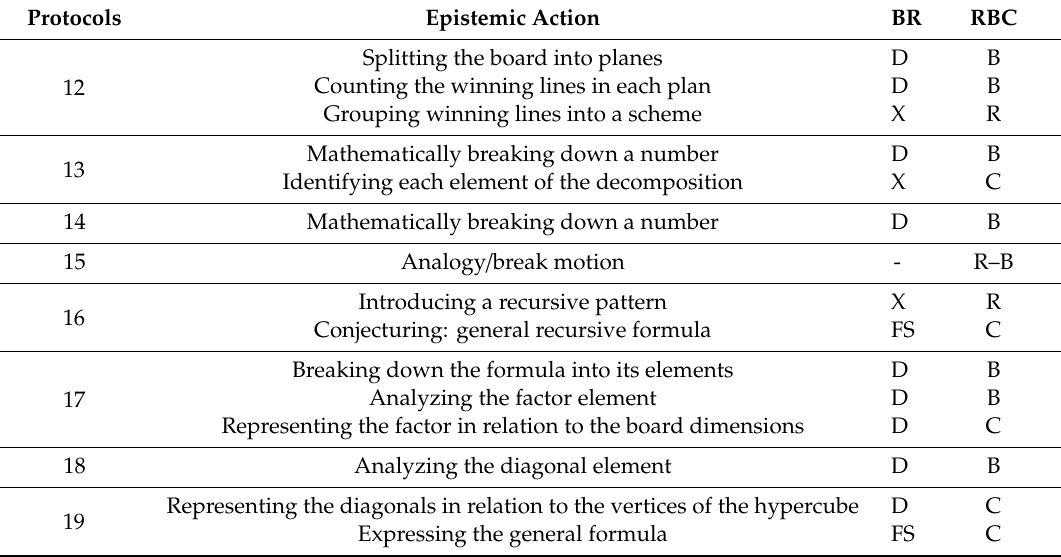
Table 4. First excerpt of Student-A protocol: analysis of epistemic actions. RBC: recognizing, building-with, and constructing; FS: backward